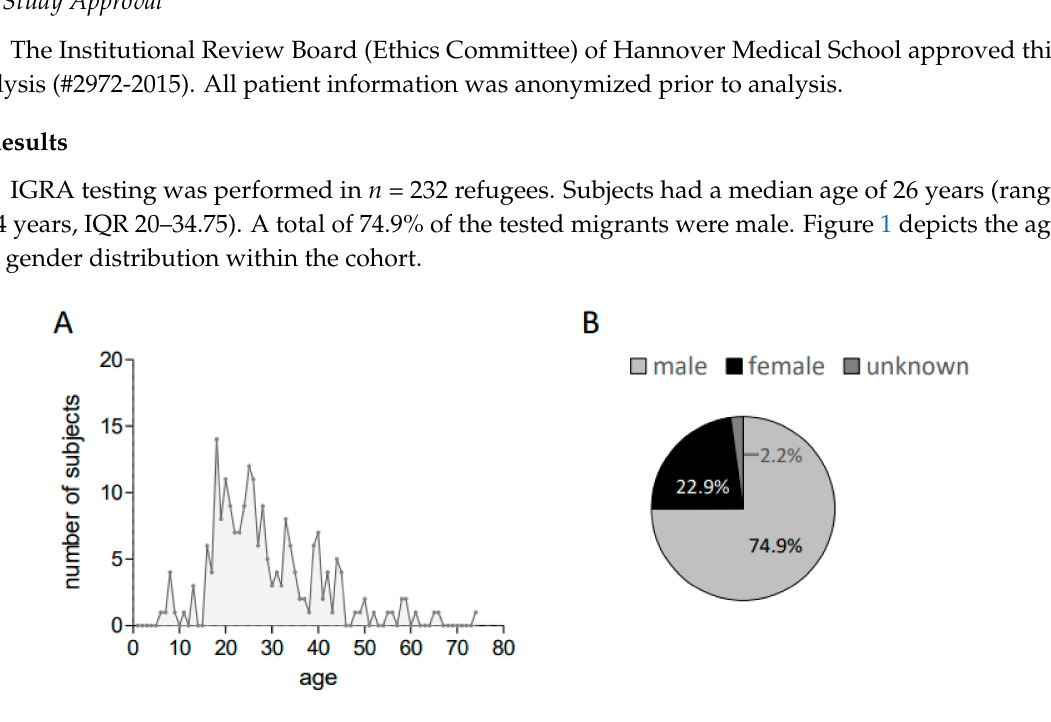
Figure 1. ( A ) The age and ( B ) gender distribution within the analyzed cohort.